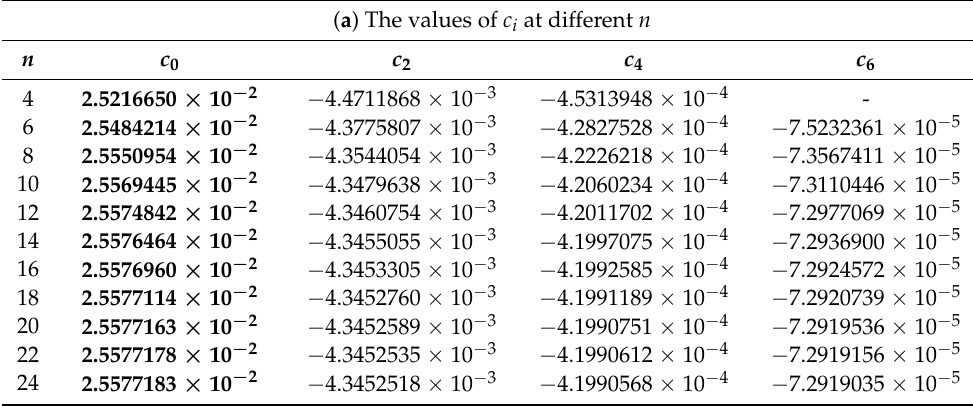
Figure 7. The values of c when = n 24 : ( a ) for = i 0,2,4,6,...,24 ; ( b ) for = i 2,4,6,...,24 . i